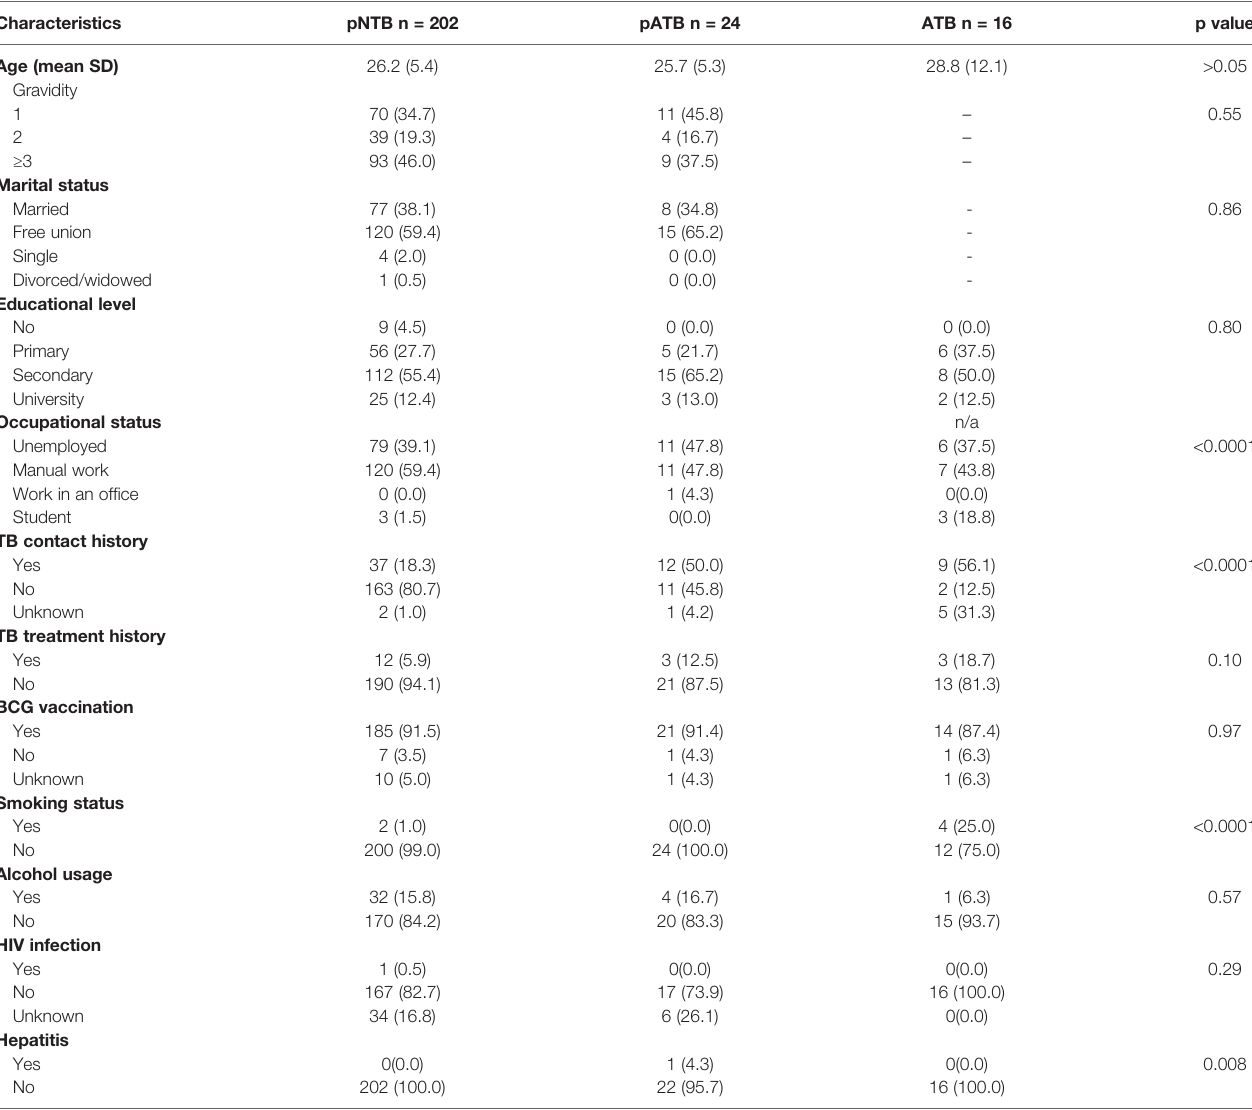
TABLE 1 | Baseline characteristics of the study participants.